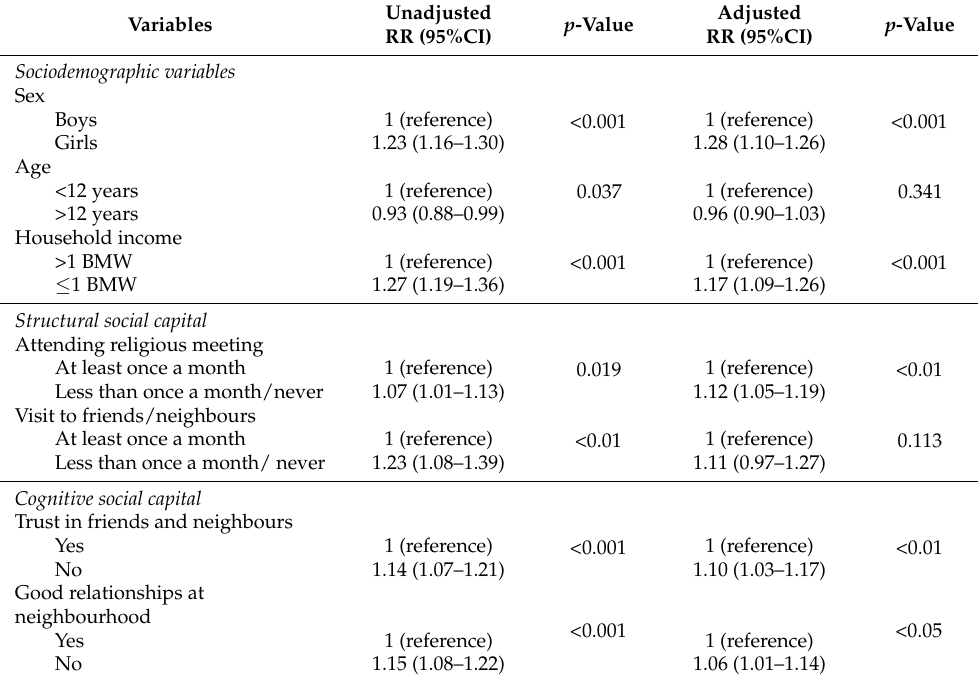
Table 3. Unadjusted and adjusted multilevel Poisson regression analysis between social capital dimensions and overall CPQ11-14